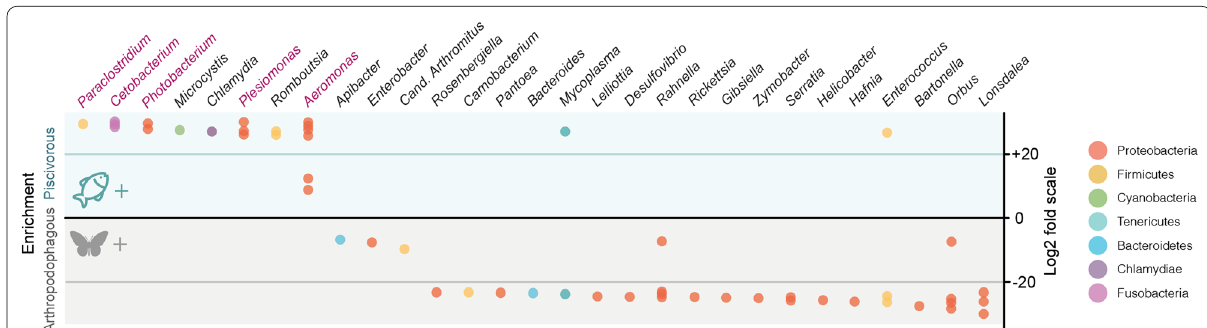
Fig. 2 Differentially abundant amplicon sequence variants (ASVs) between piscivorous and arthropodophagous bats displayed at the bacterial genus level. Only ASVs with a significance value of p < 0.01 are shown. Positive values indicate genera that were enriched in piscivorous bats, while negative values show those enriched in arthropodophagous bats. Colours of the circles indicate phyla. Each circle represents a single ASV, thus multiple circles within a genus indicate multiple ASV that were enriched. The five highlighted bacterial genera are the ones that contributed the most to the ensemble predictive models of piscivorous